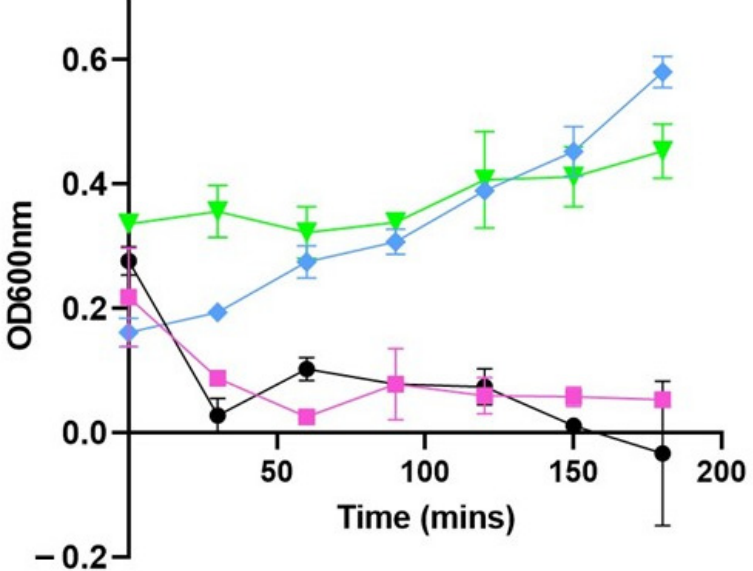
Figure 1. Experiment 1A: turbidity reduction assays performed at 37 ◦ C using 1 × 10 7 CFU/mL L. monocytogenes 473 (serotype 4e). The data have been adjusted according to Equation (1). L. monocytogenes strain 473 was inoculated into TSB containing PHA_lysin293_BNPs (pink symbols) ( n = 4), PHA_amidase293_BNPs (black symbols) ( n = 4), L. mono + PHA_BNP control (green symbols) ( n = 4), and L. mono-PHA_BNPs (blue symbols) ( n = 4). Absorbance at OD 600 nm was measured at 0, 30, 60, 90, 120, 150 and 180 min.